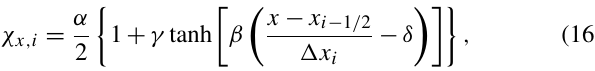
Figure 2. CIP scheme as a kind of semi-Lagrangian